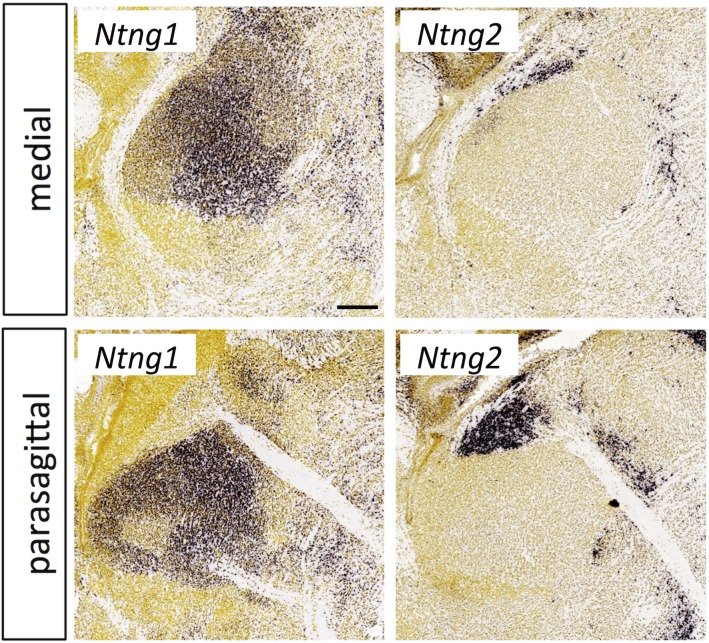
Netrin-G expression in the thalamus at E18.5.In situ hybridization data from sagittal sections of the thalamus at E18.5 obtained from the devABA revealed differential patterns of expression of Netrin-G (Ntng) 1 and 2. See text for details. Two representative and equivalent sections are shown for each netrin-G, one medial and the other adjacent medially (see S8 Fig for details on how the sections were selected). Scale bar in Ntng1: 255 μm.